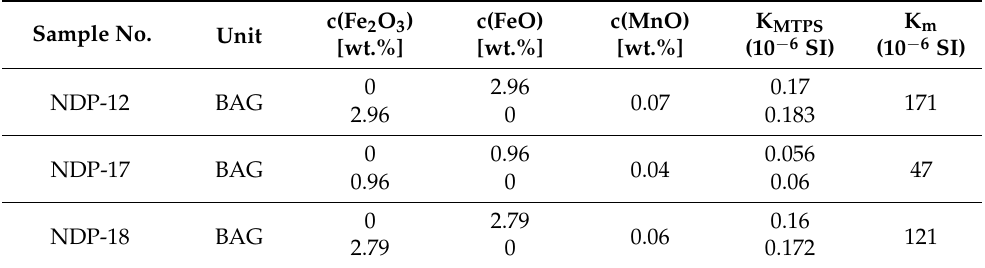
Maximum theoretical paramagnetic susceptibilities calculated using formula (6) by [112] from chemical analyses of representative Serre granitoids compared with the AMS measured